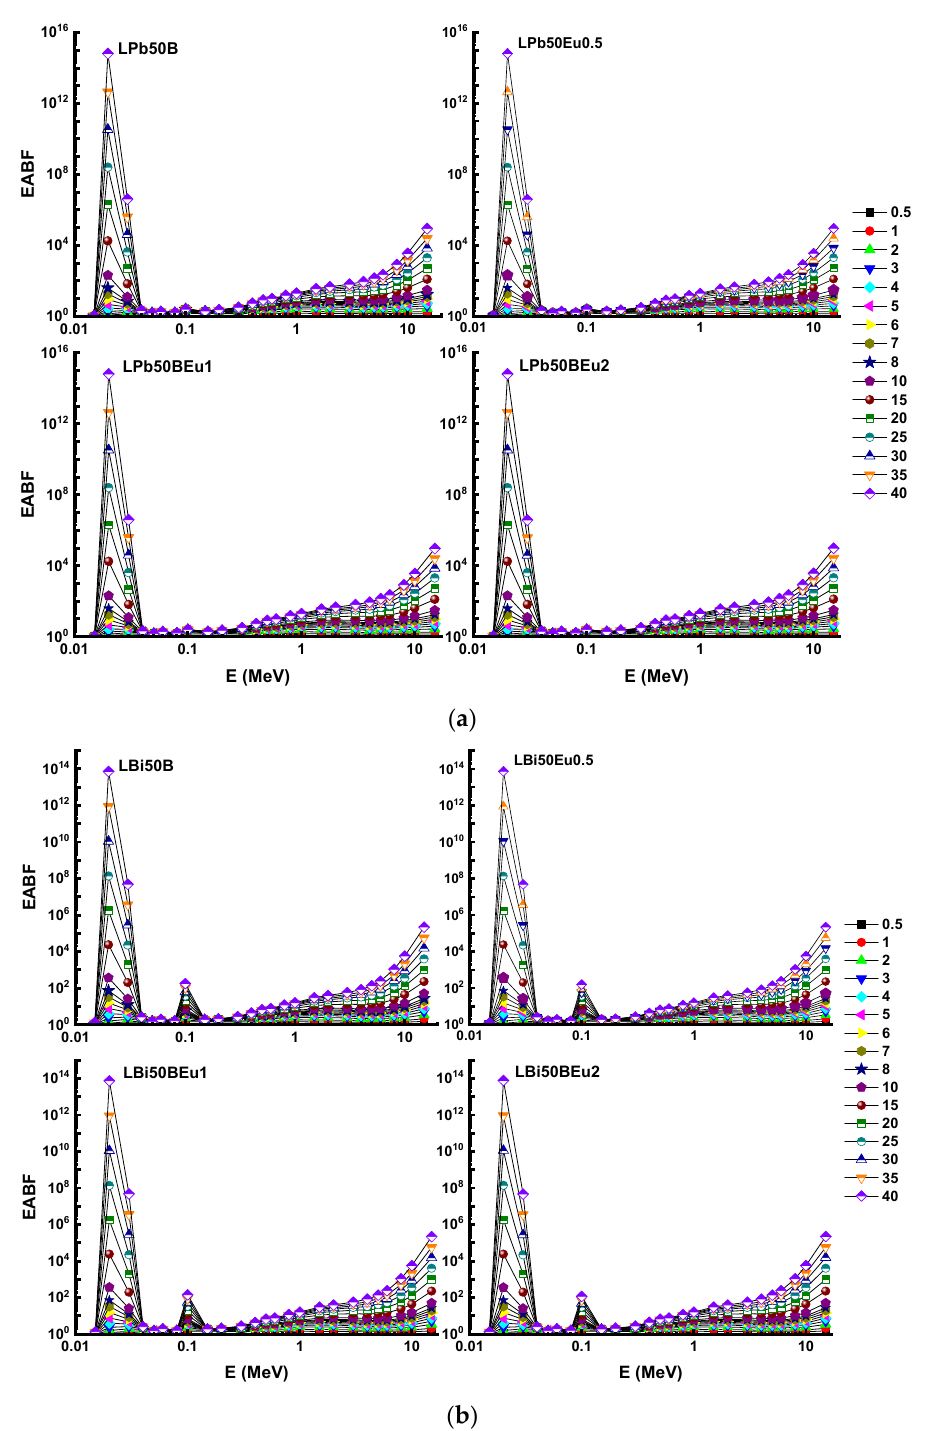
Figure 8. Variation of energy absorption build-up factor (EABF) against photon energy for ( a ) LPb50BEu and ( b ) LBi50BEu